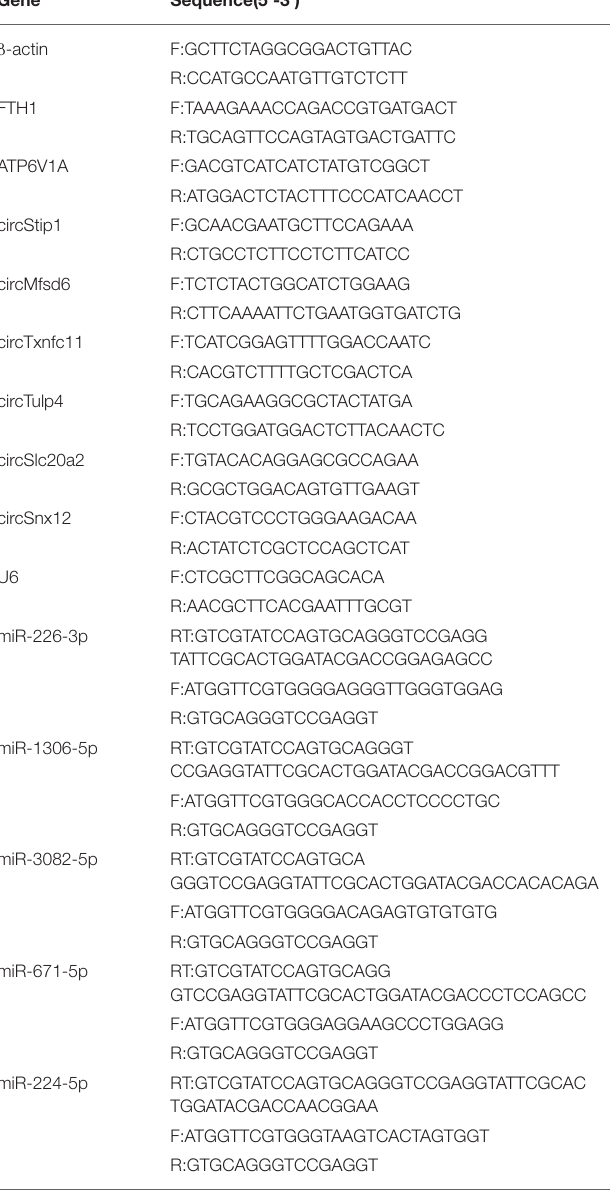
TABLE 2 | Primer sequences of circRNA, miRNA, mRNA, and internal reference used for validation by qRT-PCR.